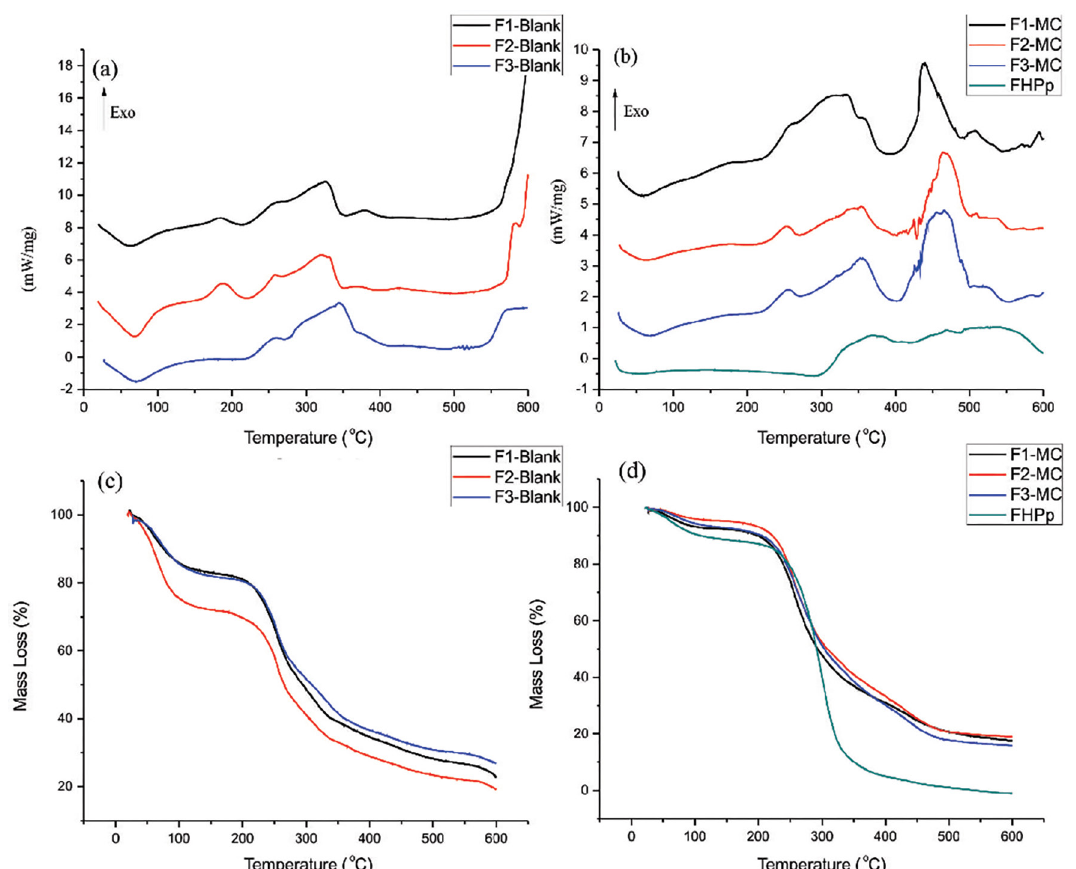
FIGURE 3 - Thermal analysis of blank microcapsules and FHPp-loaded microcapsules. DSC blank microcapsules (a), DSC FHPp- loaded microcapsules (b), TGA blank microcapsules (c) and TGA FHPp-loaded microcapsules